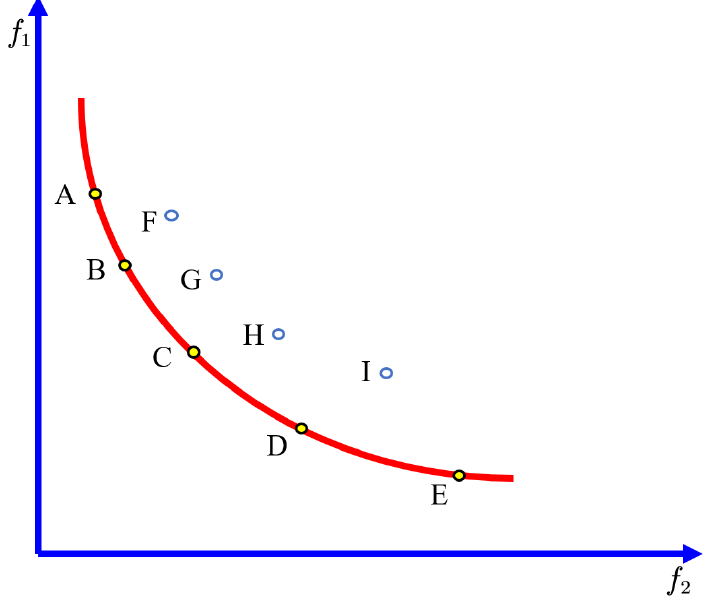
Figure 4. The Pareto frontier demonstration.